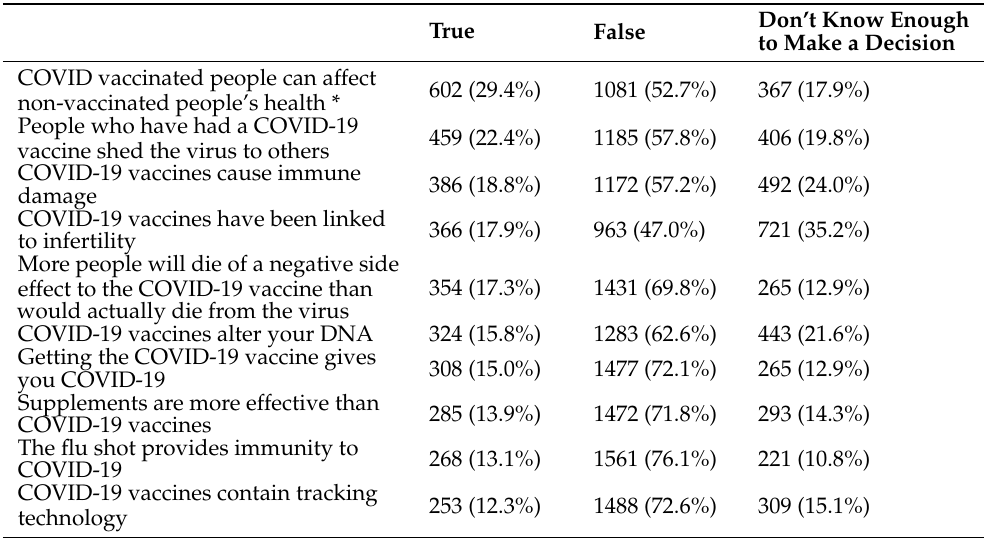
Table 5. Agreement with COVID-19 vaccine misbeliefs.